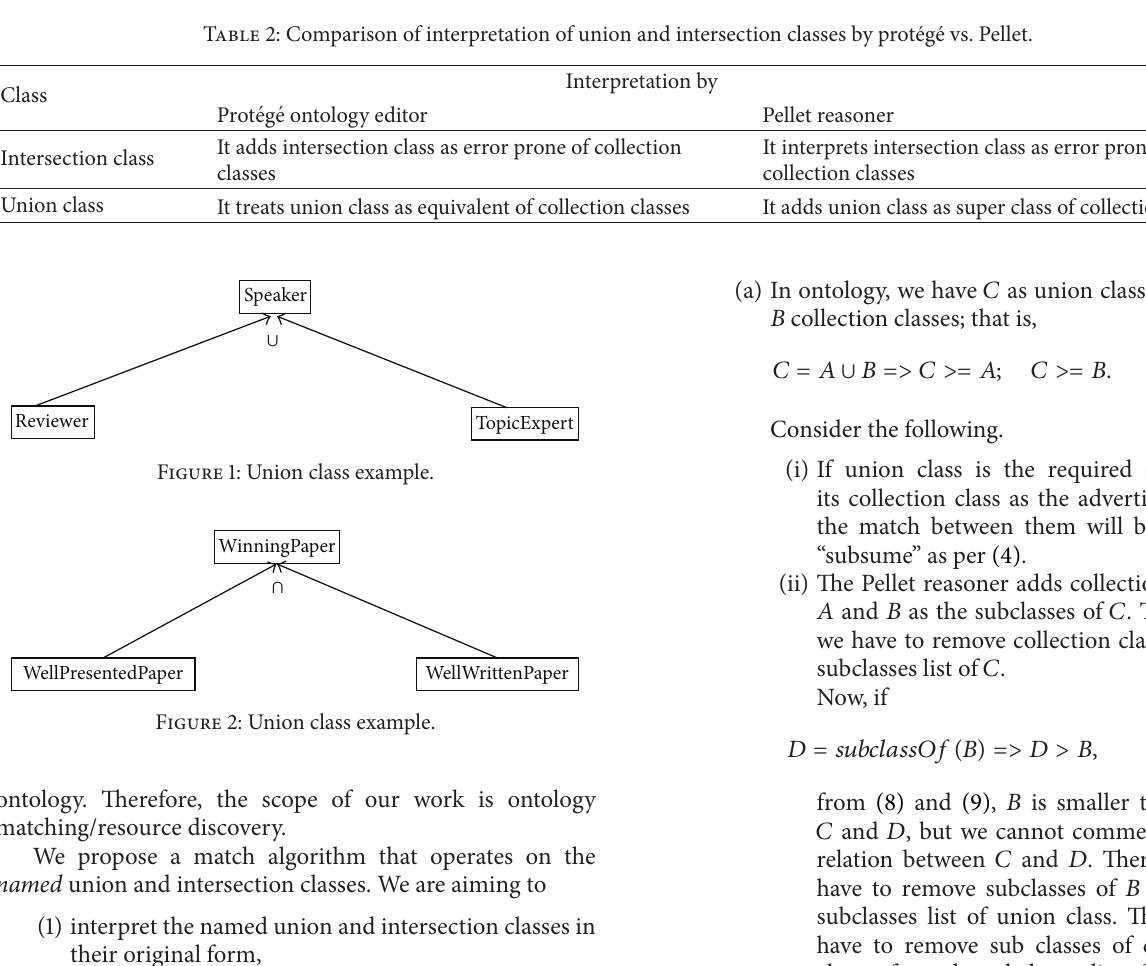
Table 2: Comparison of interpretation of union and intersection classes by prot´eg´e vs. Pellet.